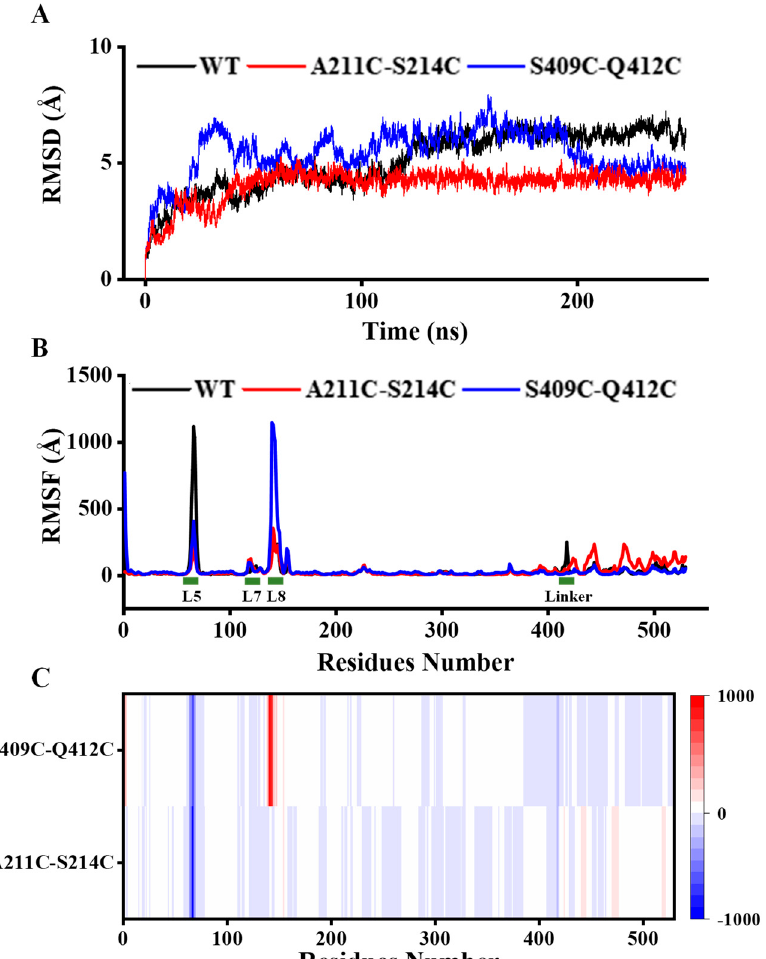
Figure 5. MD simulation analysis of wild-type MFA ps and mutants. ( A ) Calculation and distribution of the RMSD values. ( B ) RMSF values of each amino acid after MD simulation processes for 200 ns. MD, molecular dynamics; RMSD, root mean square deviation; RMSF, root mean square fluctuation. ( C ) Heat map showing the Δ RMSF of mutants relative to WT, highlighted red for Δ RMSF > 0, blue for Δ RMSF < 0, and white for Δ RMSF = 0, and the darker the color, the greater the absolute value of Δ RMSF. WT: wild-type MFA ps .